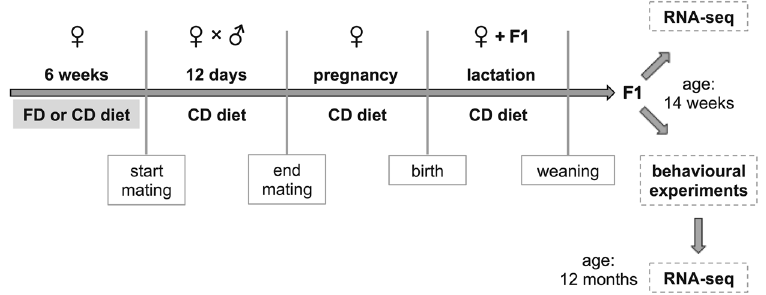
Figure 1. Schematic illustration of the study